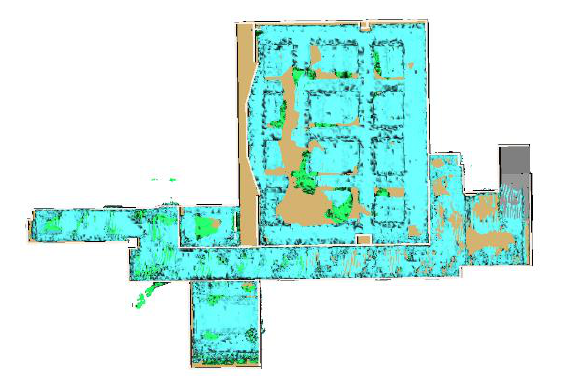
Figure 9. Hololens mesh (in cyan colour) registered with the reference 3D